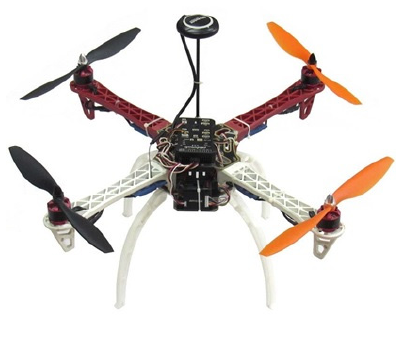
Figure 8. Prototype of proposed quadrotor.